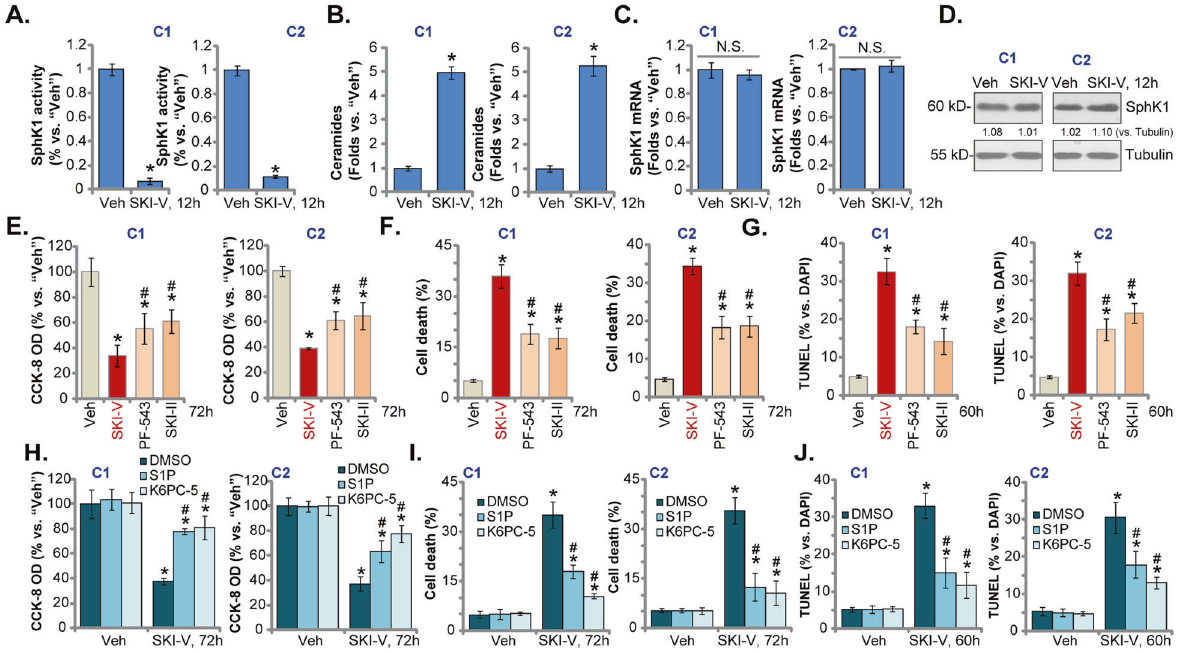
Fig. 4 SphK1 inhibition in SKI-V-treated OS cells. The primary OS cells ( “ C1 ” / “ C2 ” ) were cultured in FBS-containing complete medium and treated with SKI-V (at 25 μ M) for applied time periods, the relative SphK1 activity ( A ) and ceramide contents ( B ) were shown; expression of SphK1 mRNA and protein was tested by qRT-PCR ( C ) and western blotting ( D ) assays. “ C1 ” and “ C2 ” primary cells were cultured in FBS- containing compete medium and treated with 25 μ M of SKI-V, SKI-II or PF-543 for applied time periods, cell viability, death, and apoptosis were tested by CCK-8 ( E ), trypan blue staining ( F ) and nuclear TUNEL staining ( G ) assays, respectively. The primary human OS cells ( “ C1 ” / “ C2 ” ) were pretreated with K6PC-5 (20 μ M), S1P (20 μ M) or vehicle control (0.1% DMSO), followed by SKI-V (at 25 μ M) treatment for 60 h/72 h, cell viability, death, and apoptosis were examined by CCK-8 ( H ) and trypan blue staining ( I ) and nuclear TUNEL staining ( J ) assays, respectively. “ Veh ” stands for the vehicle control. Data were presented as mean ± standard deviation (SD, n = 5). * P < 0.05 vs. “ Veh ” . # P < 0.05 vs . SKI-V group ( E – G ). # P < 0.05 vs . “ DMSO ” group ( H – J ). “ N. S. ” stands for non-statistical difference ( P > 0.05). Experiments in this Figure were repeated fi ve times with similar results